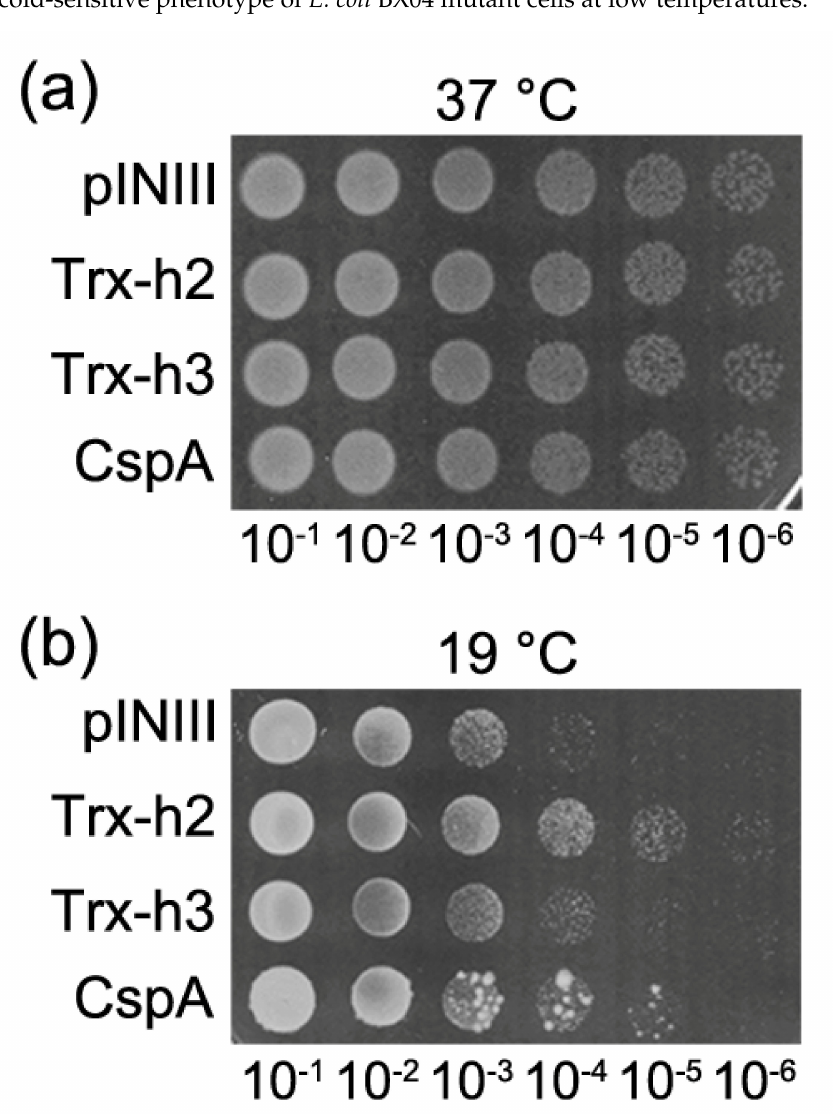
Figure 4. Trx-h2 restores the cold-sensitive phenotype of E. coli BX04 mutant cells lacking four cold-shock protein ( Csp ) genes. ( a , b ) Images showing the growth of E. coli BX04 cells expressing Trx-h2 on LB-agar media at 37 ◦ C for 1 day ( a ) and at 19 ◦ C for 5 days ( b